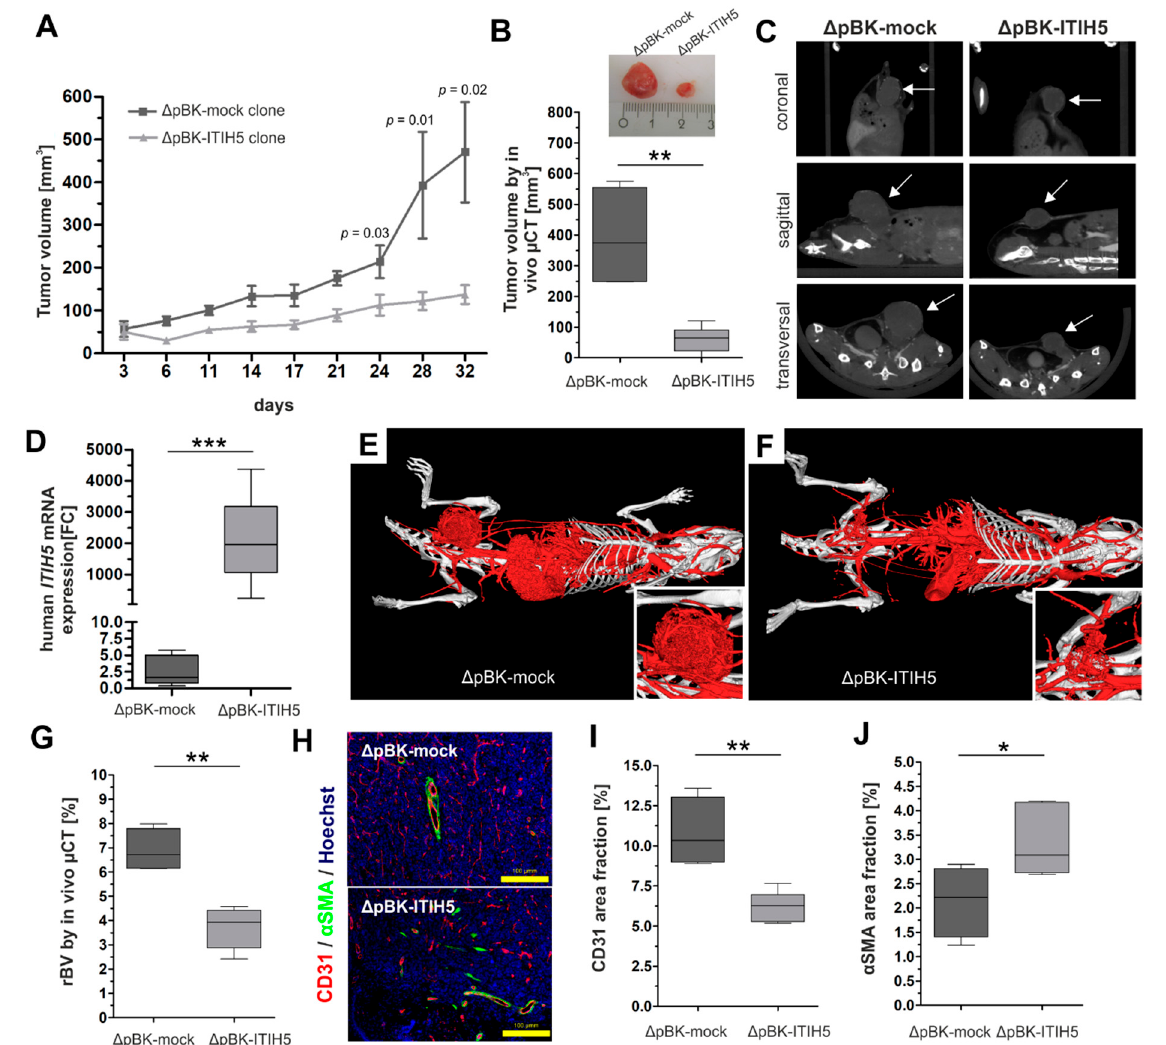
Figure 1. Full-length ITIH5 suppressed tumor cell growth in vivo. A tumorigenesis model was established to analyze the tumor growth of breast cancer cells either overexpressing ITIH5 or lacking ITIH5 expression and transplanted into the mammary fat pad. Tumor volume was determined by both using a caliper ( A ) and µCT imaging ( B , C (see arrows)), showing the significantly decreased tumor growth of MDA-MB-231 breast cancer cells transfected with ITIH5. ( D ) ITIH5 overexpression in tumors grown in the mouse model was confirmed by qPCR analysis. In order to assess the putative effects of ITIH5 on the mechanisms of neovascularization, which may impact growth rates in vivo, we visualized the vascular system by contrast-enhanced µCT imaging ( E , F ) and calculated the relative blood volume (rBV) ( G ) between both groups. ( H ) Immunofluorescence staining of the markers involved in blood vessel maturation, i.e., CD31 (a specific marker for vascular structures) and α SMA (a specific marker for vascular differentiation). Hoechst dye was used to stain the nuclei. ( I ) The staining intensity of CD31 ( H ) was analyzed for tumors derived from either Δ pBK-mock (dark grey) or Δ pBK-ITIH5 clones (grey), shown as the area fraction. ( J ) The correlation analysis between relative blood volume (rBV) determined by µCT and the CD31 area fractions showed a significant association in the tumors of both groups. * p ≤ 0.05; ** p < 0.01; *** p < 0.001.